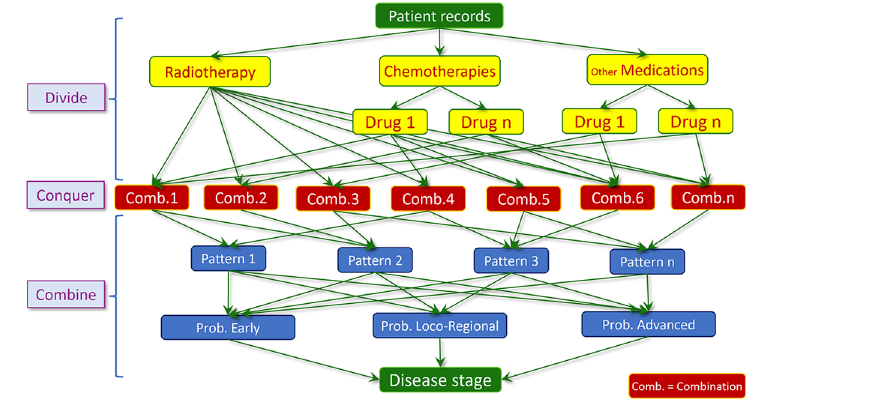
Fig 2. The processes of patient